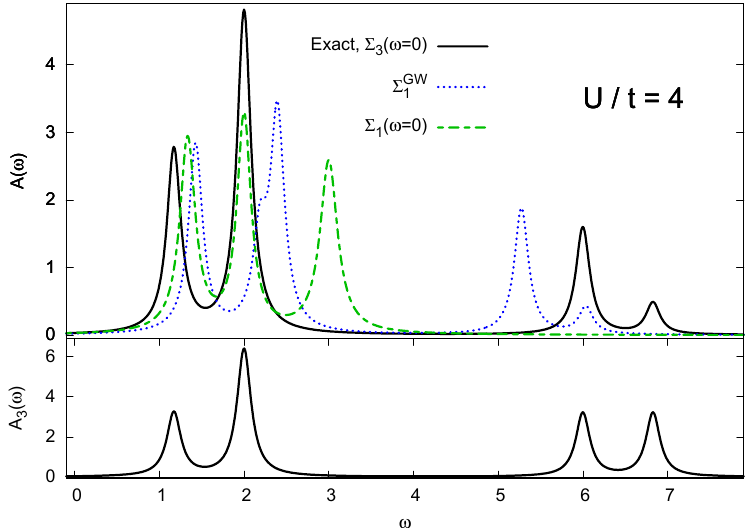
Figure 3: The addition part of the the 1- and 3-body spectral functions for the Hubbard dimer at 1/4 filling at strong interaction ( U / t = 4 ). Top panel: the spec- tral function A ( ω ) obtained with various levels of theory: the exact 1-GF and the 1-GF obtained from the exact static 3-SE (black solid line); the GW approximation (blue dotted line); the exact static 1-GF (green dashed line). The rightmost peak is a satellite. Bottom panel: the exact 3-body spectral function A = 1 correspond to ε 0